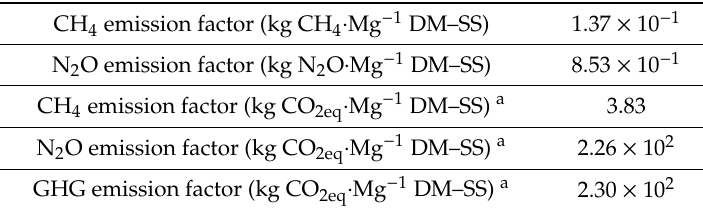
Table 2. CH 4 and N 2 O emission factors, expressed in kg of pollutant per Mg of dry matter of sewage sludge (DM–SS) and in kg of CO 2 equivalent per Mg of dry matter of